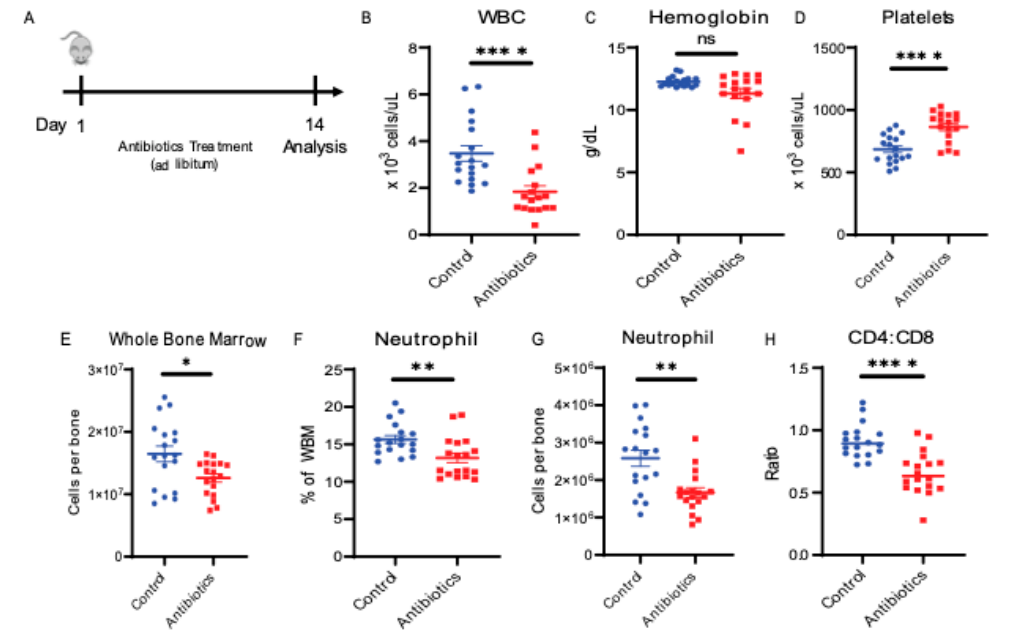
Figure 1. Antibiotic administration alters peripheral blood and bone marrow cell composition. ( A ) Antibiotic treatment experiment design. ( B ) White blood cell counts (WBC), ( C ) hemoglobin, ( D ) platelet counts from peripheral blood using automated hematologic cell counter and compared between control vs. antibiotic-treated (antibiotics). ( E ) Whole bone marrow (WBM) cells comparing control vs. antibiotics were counted using automated cell counter. ( F , G ) Neutrophil population from WBM for control vs. antibiotics are shown using flow cytometry. ( H ) CD4:CD8 ratio in WBM for control vs. antibiotics are shown using flow cytometry. Results are compiled from 3 independent experiments ( n = 5–8 per experiment). Graphs show mean + SEM. Statistical significance was determined by Mann–Whitney U test. ns, not significant, * p < 0.05, ** p < 0.01, **** p < 0.0001.